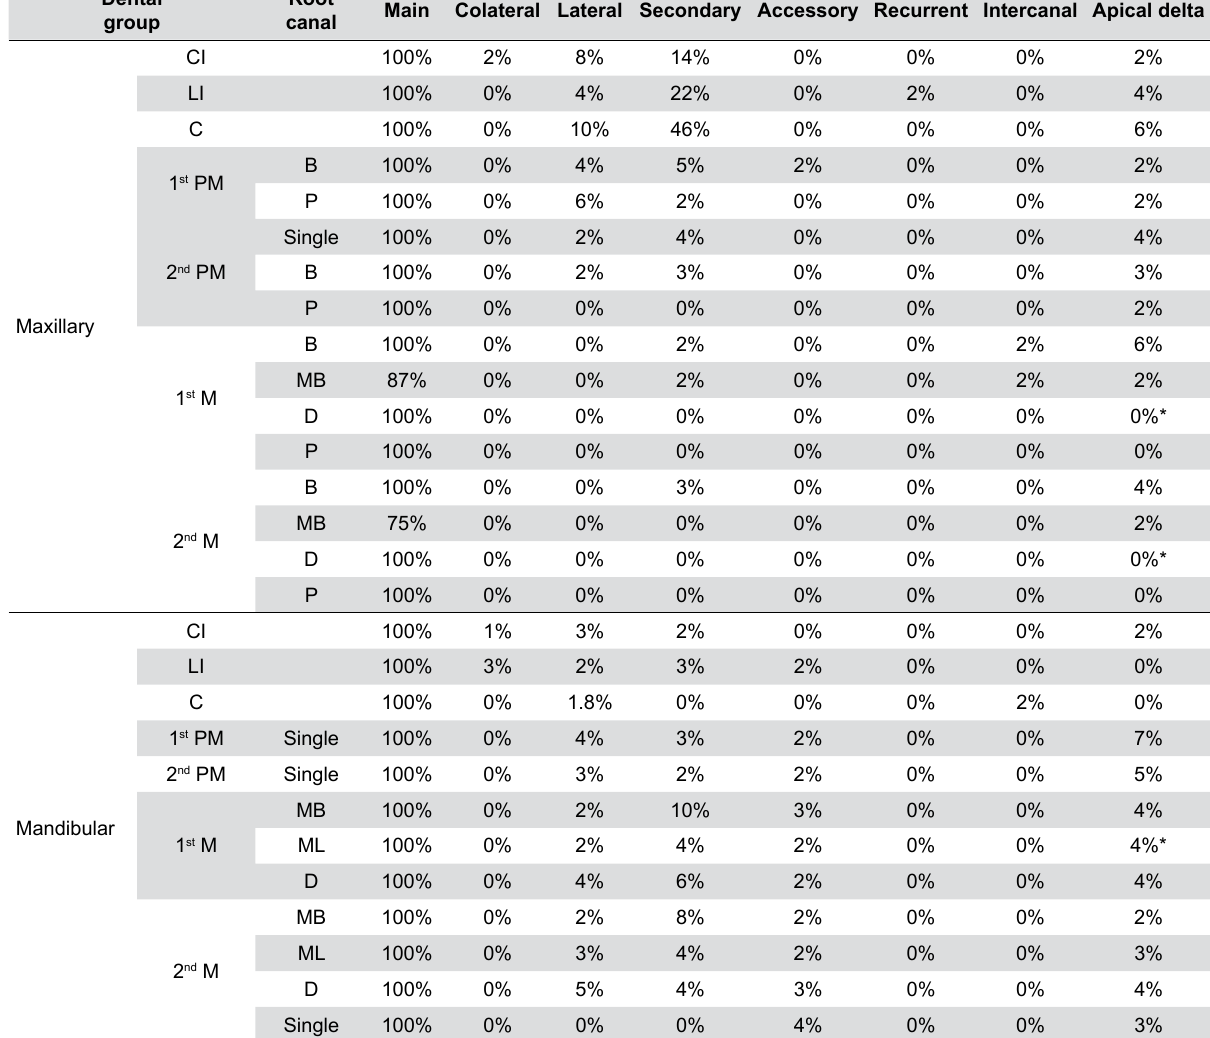
Table 1- Percentage distribution of root canal types found according to the Pucci & Reig (1944)